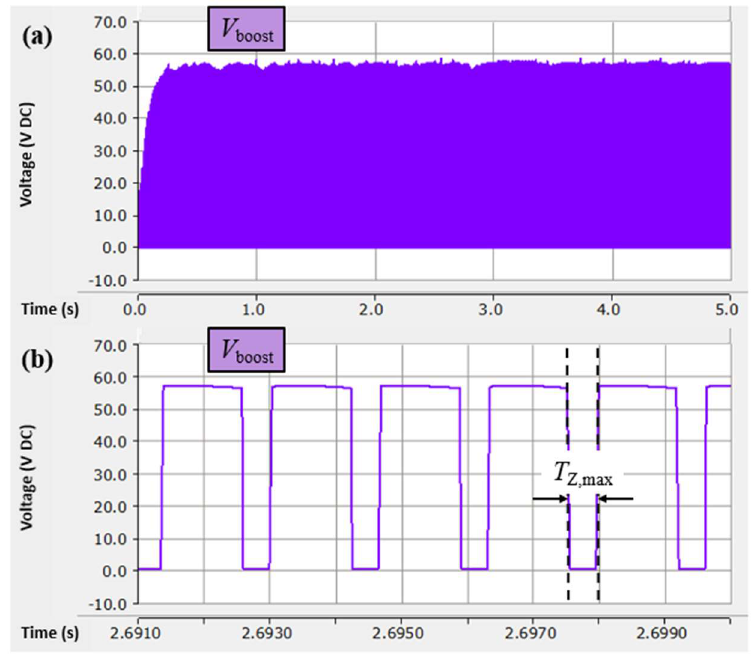
Figure 15. DC-link voltage: (a) Voltage waveform. (b) Zoomed-in voltage transient of the waveform.